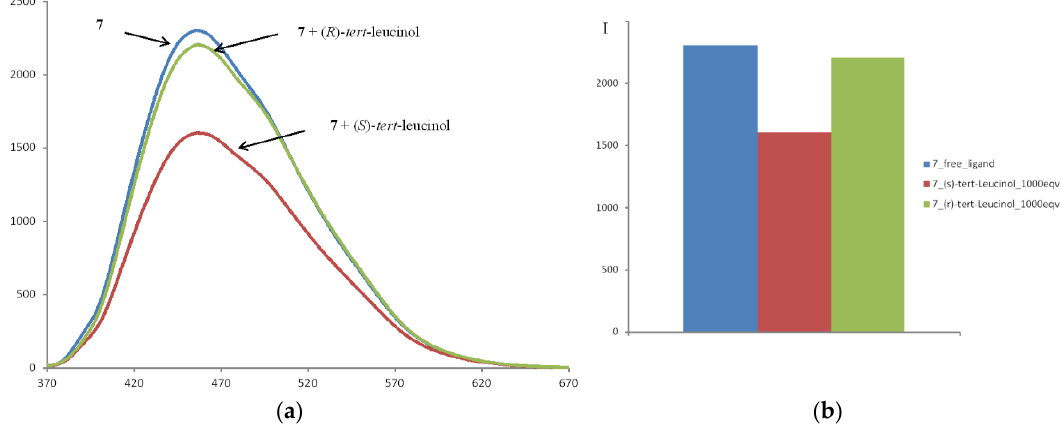
Figure 2. Fluorescence spectra of compound 7 in the presence of ( R )- and ( S )-enantiomers of tert -leucinol (1000 equiv.); ( a ) general view; ( b ) schematic representation of the changes in emission.